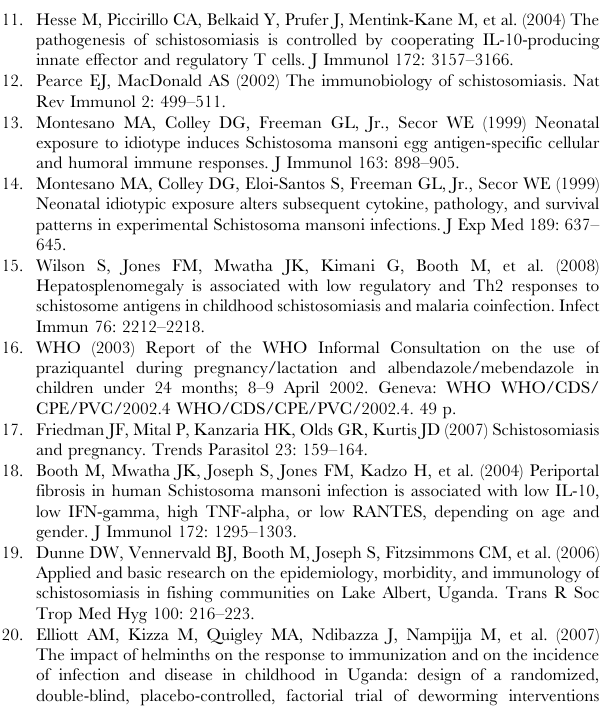
Figure S3 Expression of FoxP3 among children infected or uninfected with S. mansoni at age 5 years. On the Y-axis is the log10 (geometric mean fluorescent intensity (GMFI) + 1). Text S1 Shown in table S1 is the association of maternal S. mansoni infection during pregnancy with cytokine responses to SWA or SEA among children (n= 229) at age five years, and in table S2 is the effect of praziquantel treatment of S mansoni during pregnancy on cytokine responses to SWA/SEA in offspring at age five